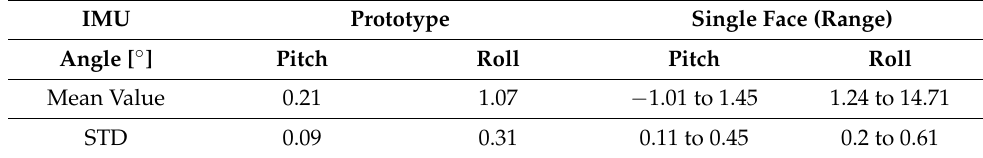
Table 5. Initial leveling procedure comparison between prototype and single